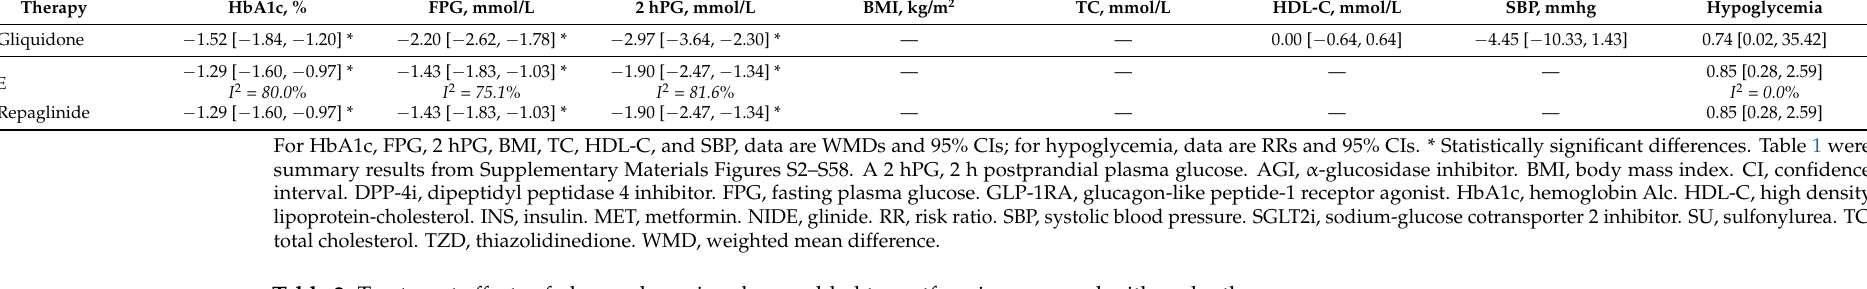
Table 2. Treatment effects of glucose-lowering drugs added to metformin compared with each